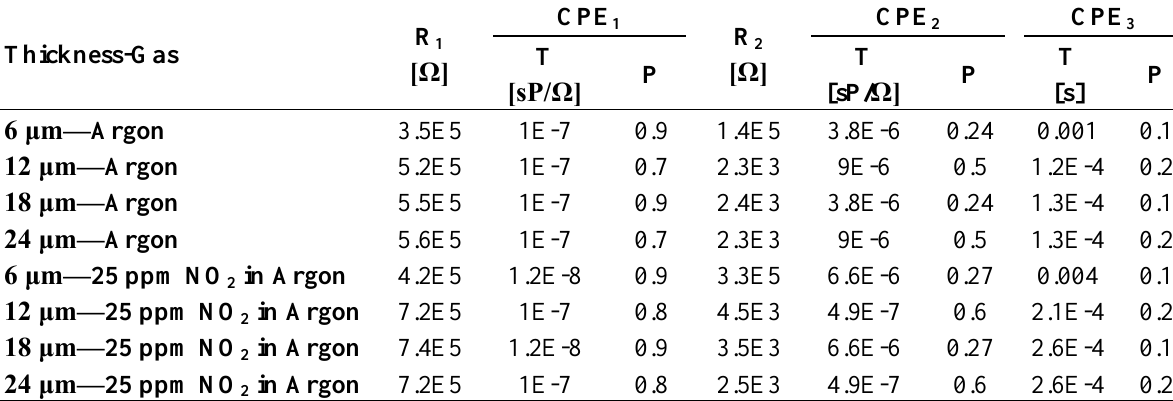
Table 1. Change in resistance (R bulk TiO depending on NTs thickness towards different amounts of NO 2 measurement. Colored columns indicate the constant values, and thus reduced diffusion.